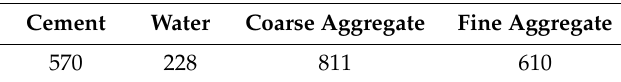
Table 2. OPC mix design (kg / m 3 ).